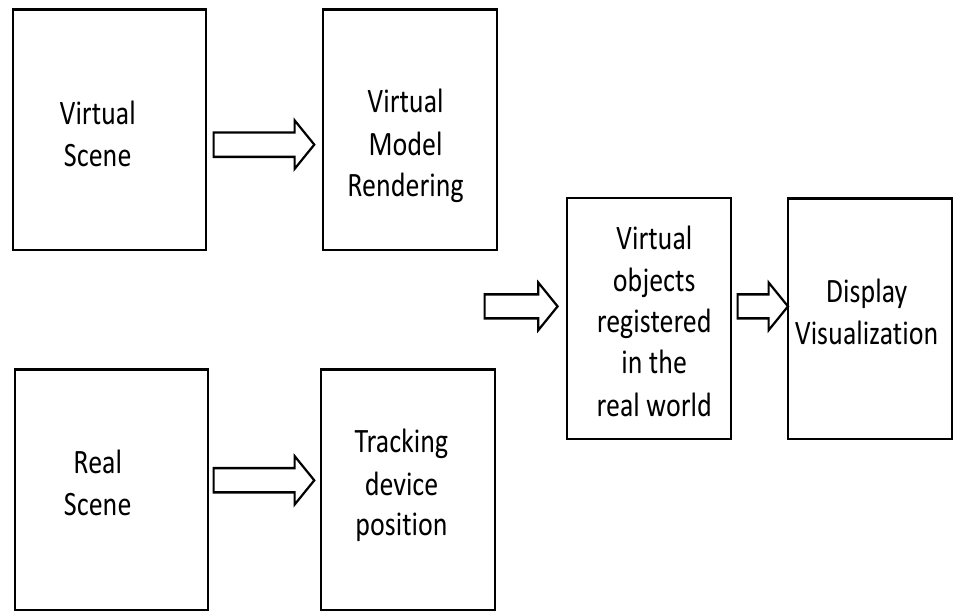
Figure 1. Workflow of augmented-reality-enabled